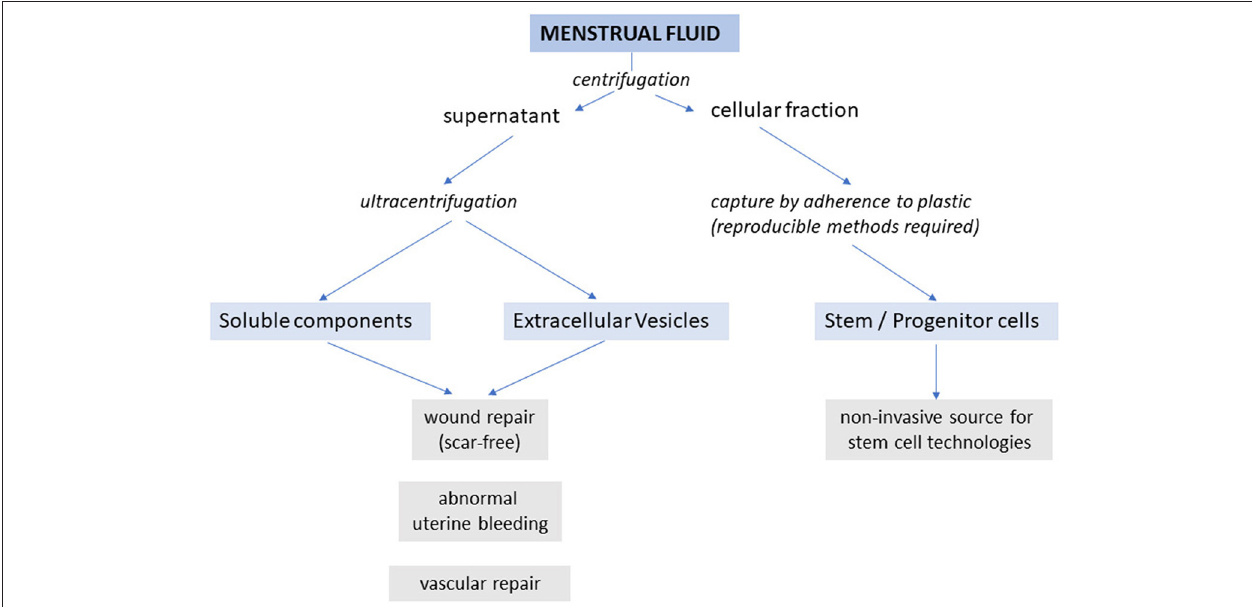
FIGURE 2 | Schematic showing potential applications of components of menstrual fluid.